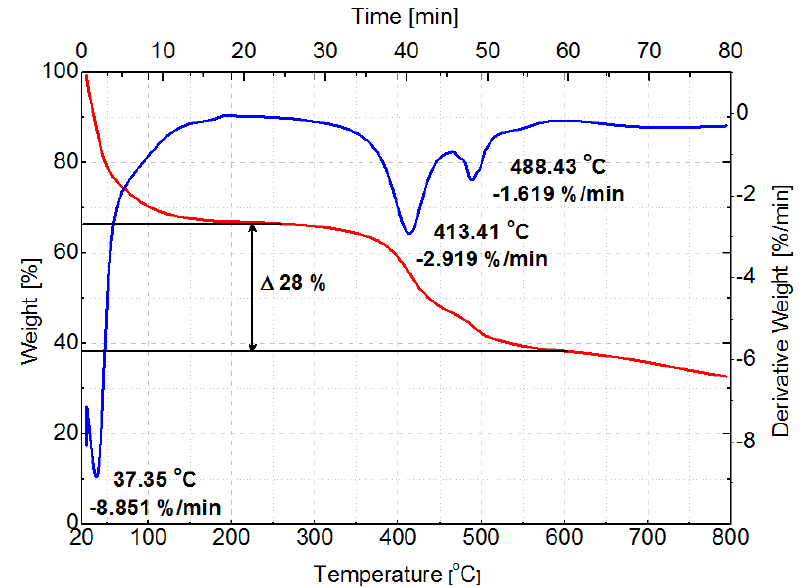
Figure 11. TGA data showing weight loss vs. temperature. The weight loss was 28%; observed shrinkage was ∼ 40%. The organic component was decomposed and removed by